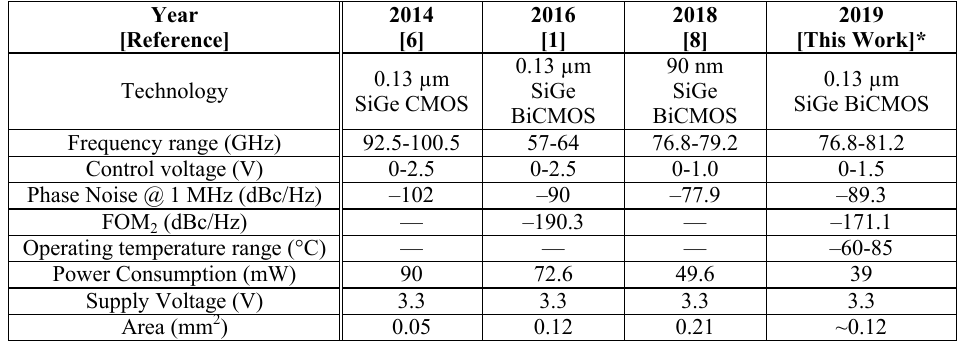
Table 1. VCO performance summary and